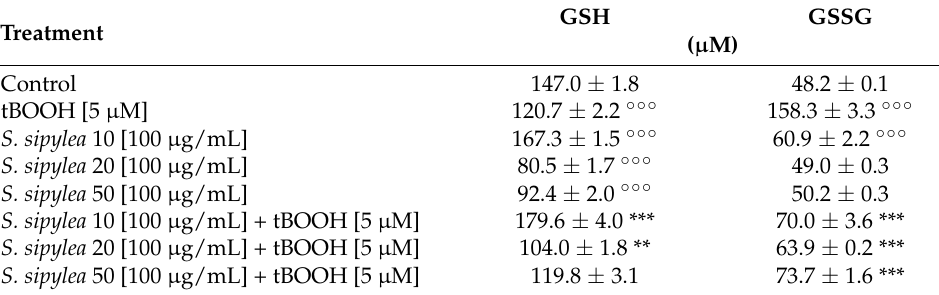
Table 4. Levels of GSH and GSSG after treatment with S10, S20, and S50 fractions from Sideritis sipylea Boiss, the pro-oxidant agent tBOOH and their combination in H69 cells. GSH and GSSH were evaluated in cell lysates, calculated with respect to the corresponding calibration curves, and normalized on cell viability. Data are mean ± SE from at least three independent experiments ( n = 3). ◦◦◦ p < 0.001 vs. control, while ** p < 0.01 and *** p < 0.001 vs. tBOOH (one-way ANOVA followed by Dunnett’s multiple comparison